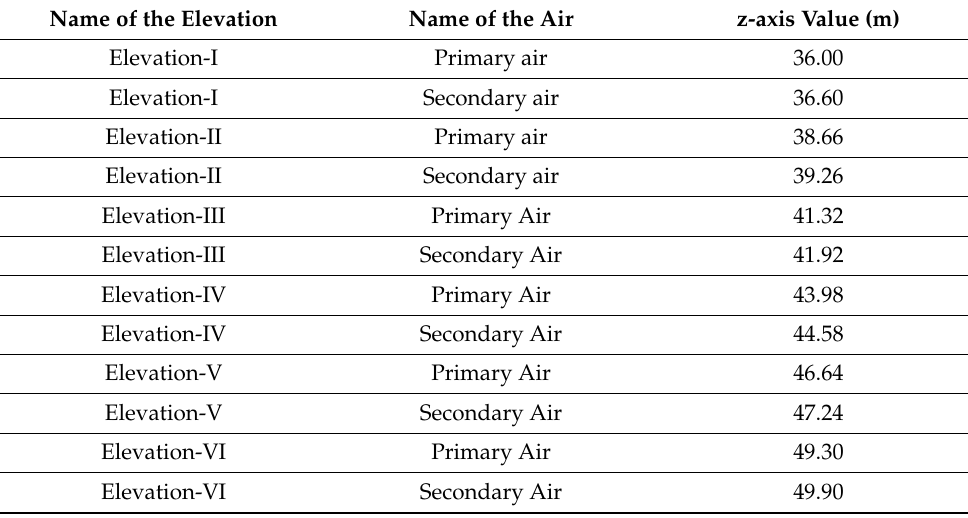
Table 4. Elevation-wise burner location in each group.